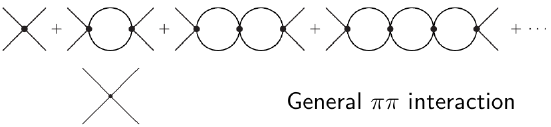
Figure 1. Unitarity loop diagrams resummed by unitarization